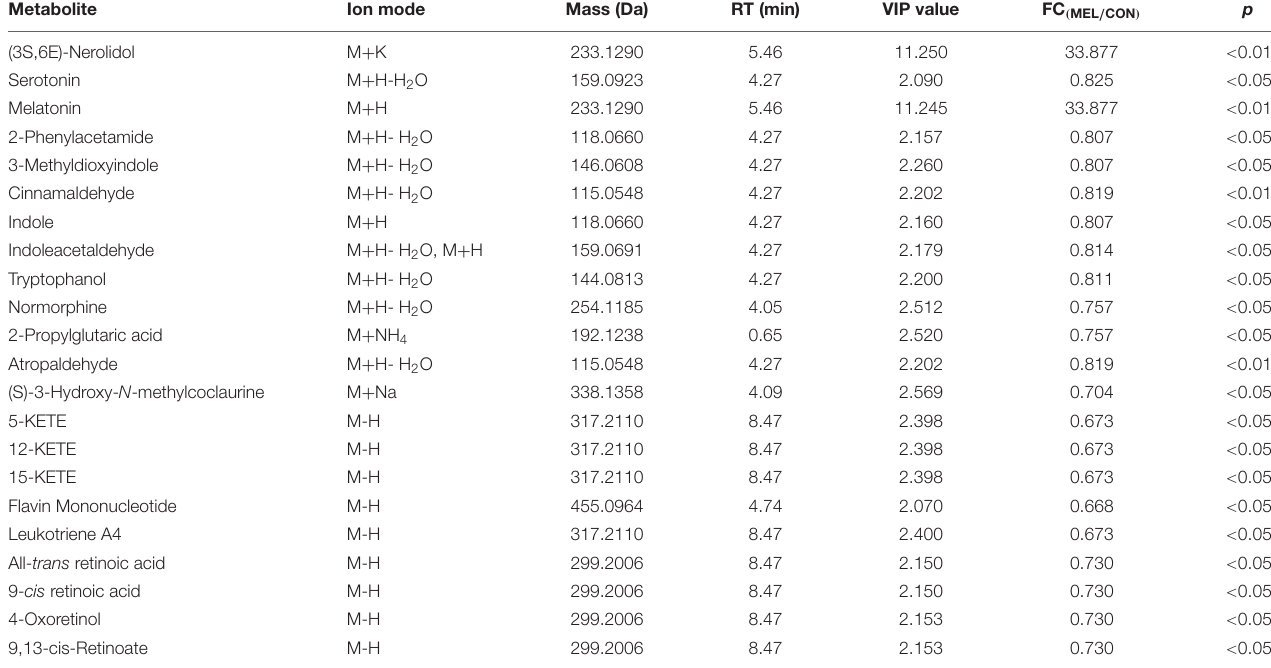
TABLE 2 | Muscle metabolites with concentrations that differed significantly between the MEL and CON